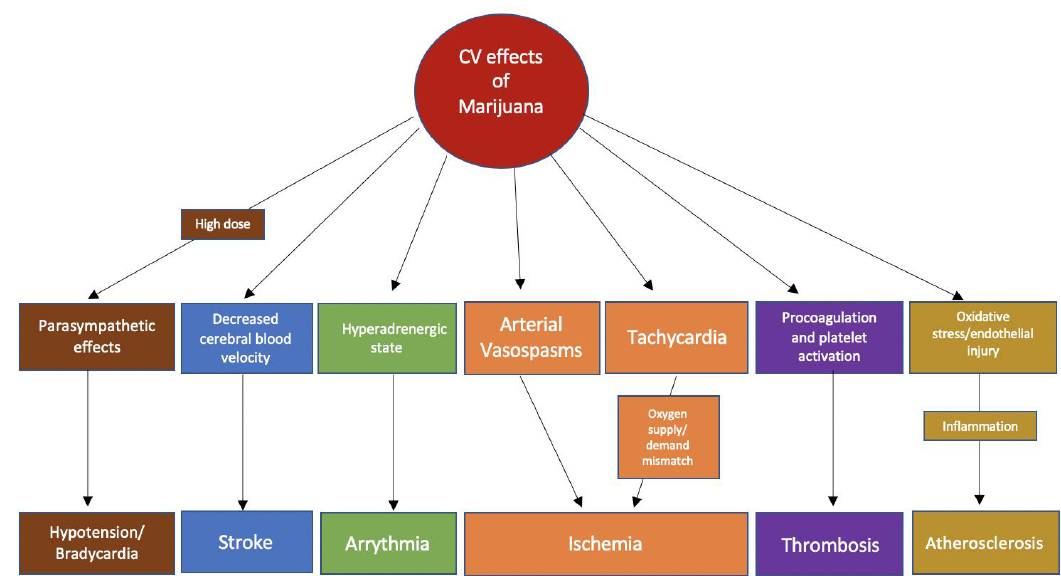
Figure 1. Possible pathophysiological mechanisms of the association of common cardiovascular events with marijuana use.